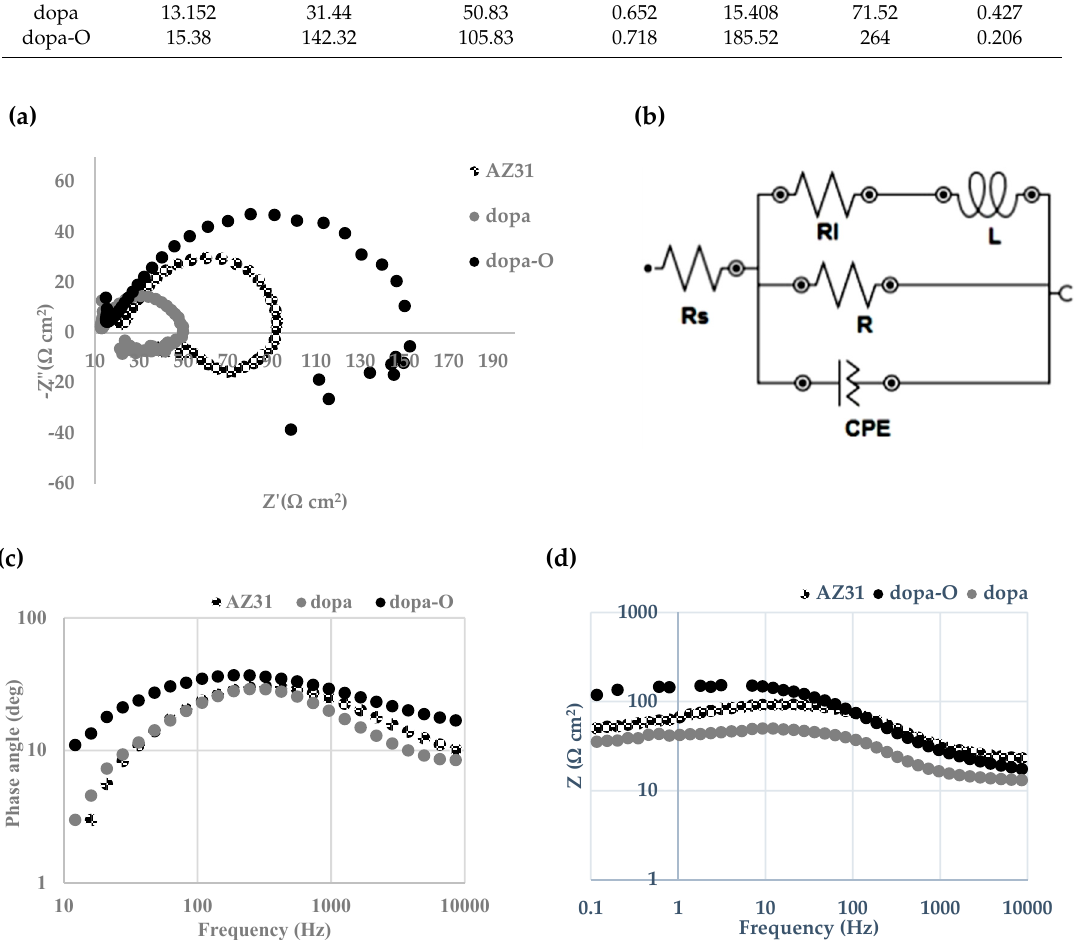
Figure 4. Electrochemical data for samples; “AZ31”, “dopa”, and “dopa-O” ( a ) Nyquist plot; ( b ) Equivalent electrical circuit; ( c ) Bode-phase angle plot, and ( d ) Bode-impedance plot.